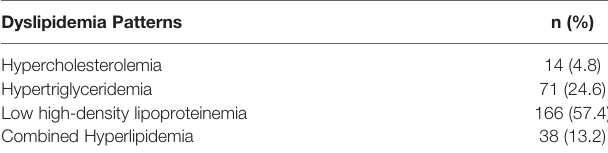
TABLE 1 | Dyslipidemia patterns in PCOS women. Dyslipidemia Patterns n (%) Hypercholesterolemia